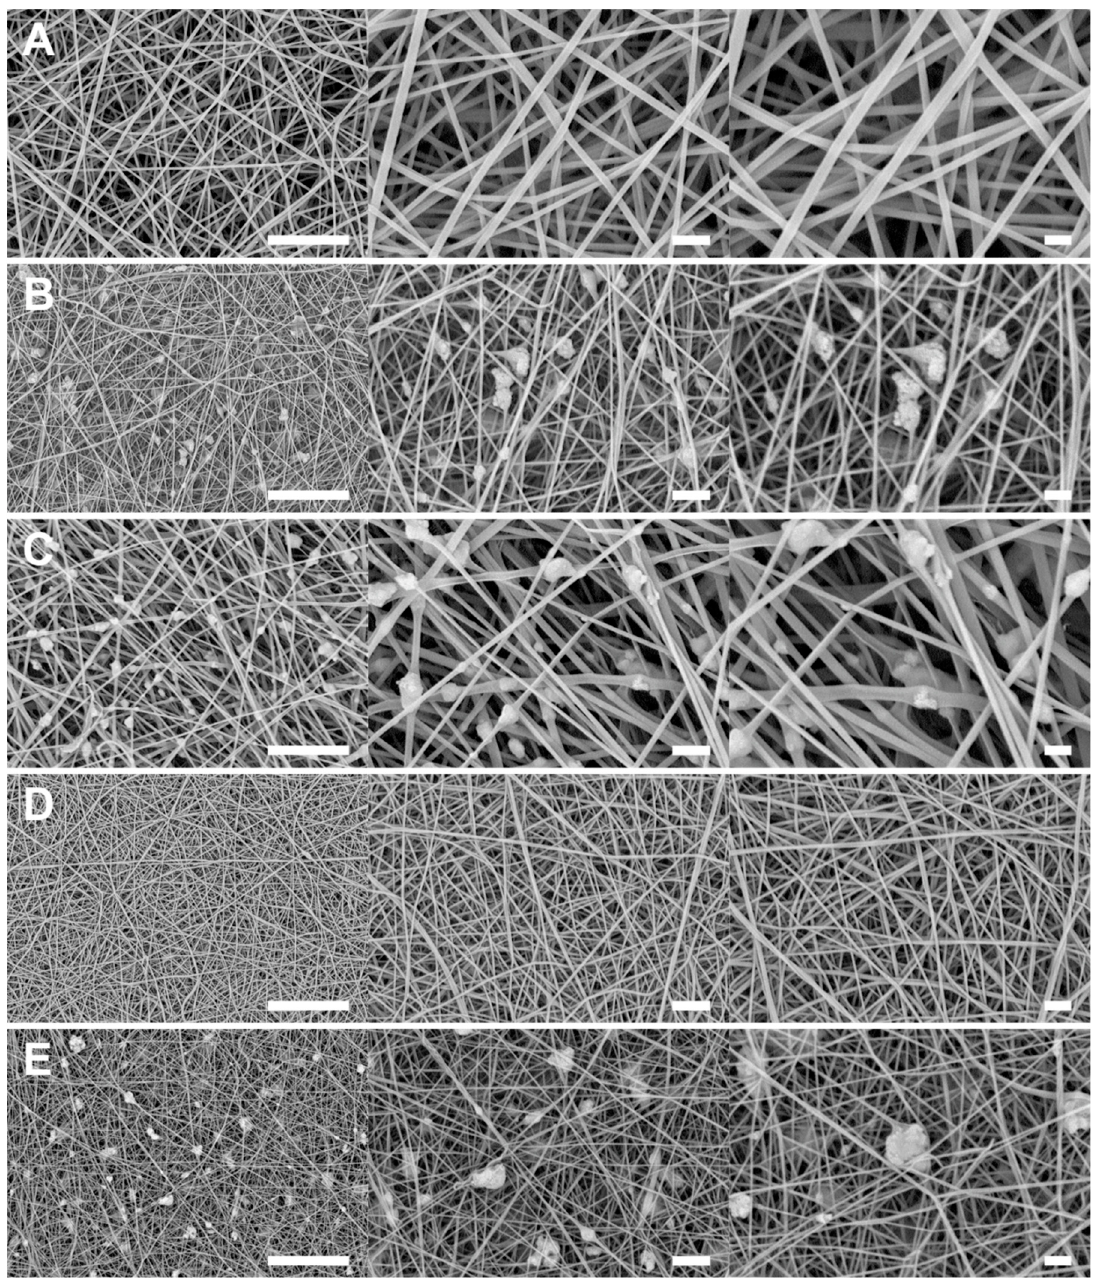
Figure 3. SEM images acquired at different magnifications of: ( A ) NYL; ( B ) NYL+TiO 2 ; ( C ) NYL + AuPd/TiO 2 ; ( D ) NYL + AuPd and ( E ) NYL + AuPd + TiO 2 . Scale bars: 10 µm (first column); 2 µm (second column) and 1 µm (third column). Table 2. NYL-based membranes: fiber average diameter and specific surface area of the electrospun samples.